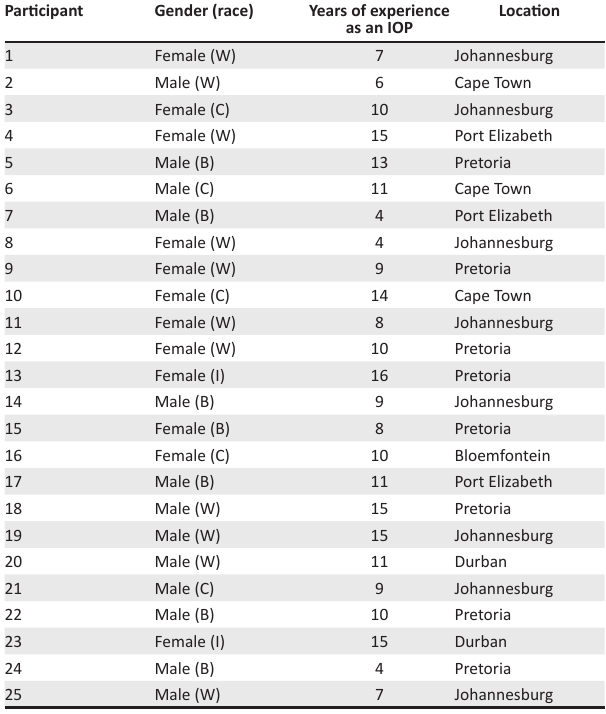
TABLE 1: Demographic characteristics of